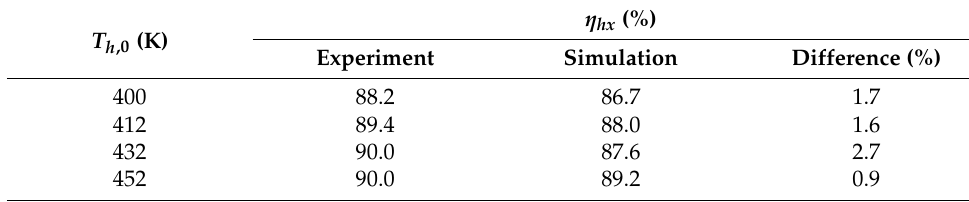
Table 5. Verification of heat exchanger